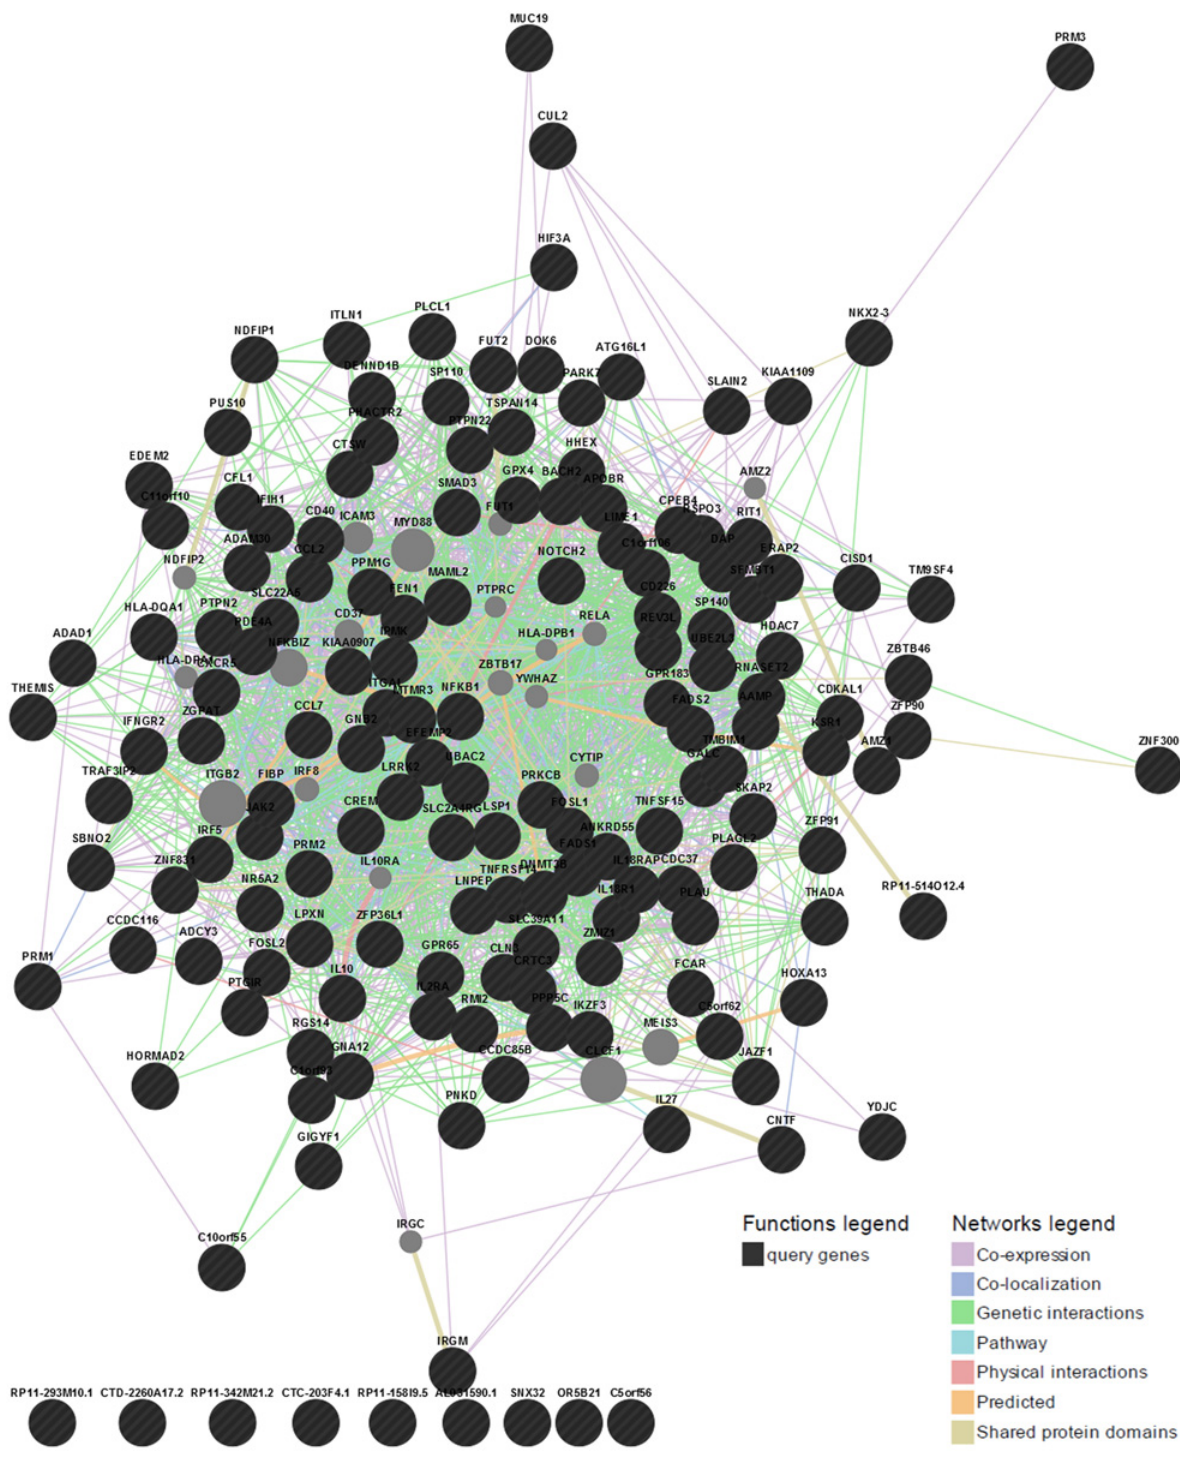
Fig 6. Gene interaction network using GeneMANIA webserver. Here genes are represented as nodes and edges indicate different types of interaction between genes. Black circles are the query genes and the color coding on edges indicate different types of interaction — which is defined in the network